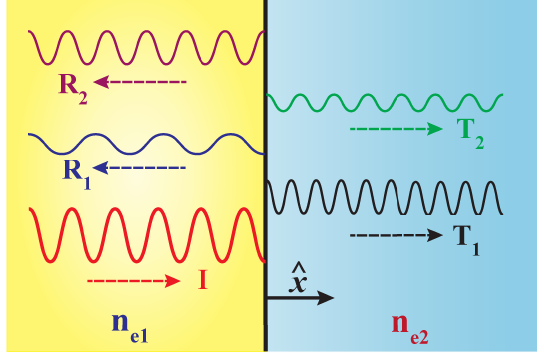
Figure 3. In contrast to figure 1, the scattering of an incident I wave at an interface separating two di ff erent electron densities, n e 1 and n e 2 , in a uniformly magnetized plasma results in two re- flected, R 1 and R 2 , and two transmitted, T 1 and T 2 ,